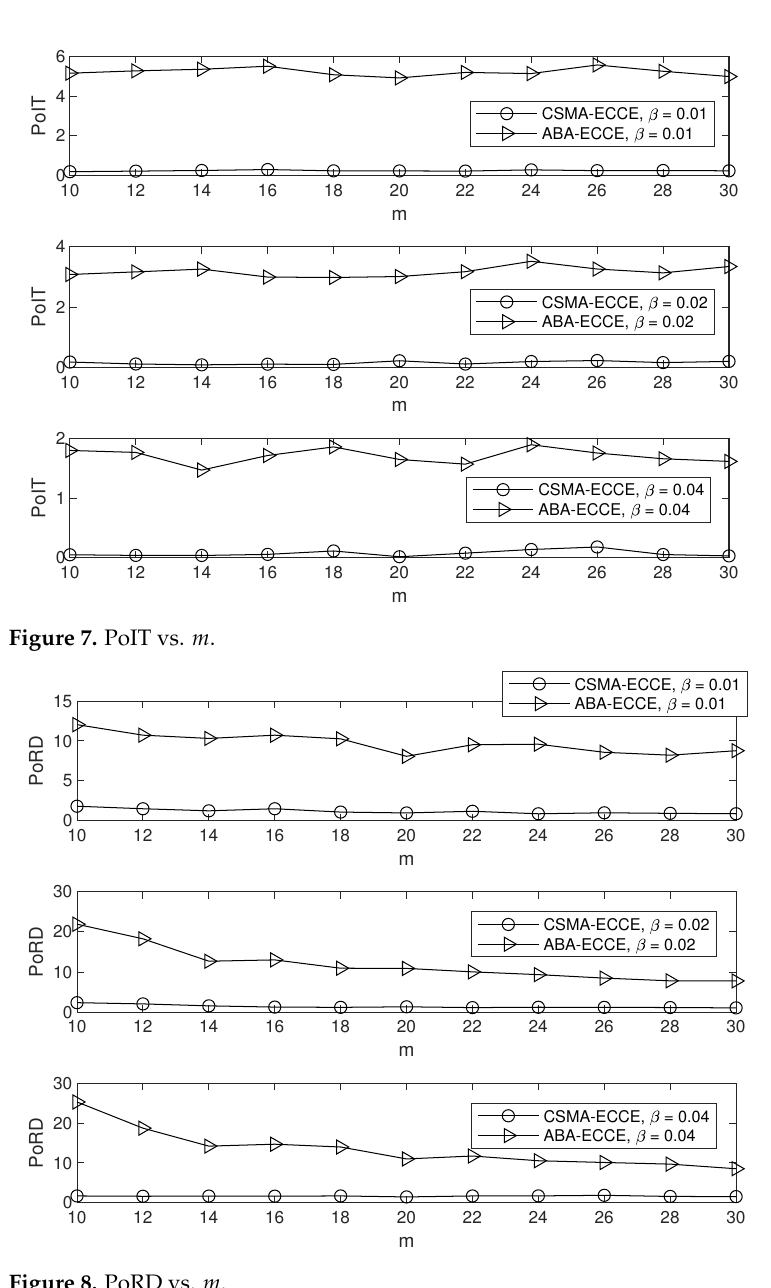
Figure 8. PoRD vs. m